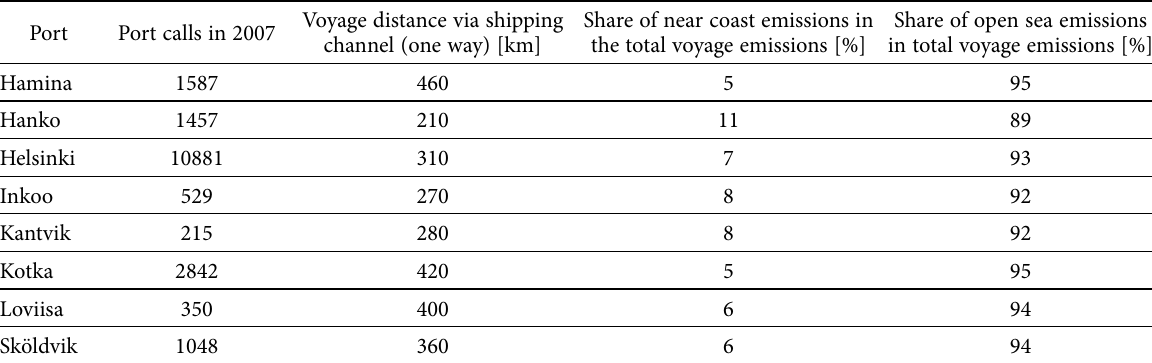
Table 1. A list of ports included in the study with a distance from each port to the Gulf of Finland exit point (see Fig. 1) and the share of the near coast (defined as the first 22.2 km of the journey from the harbour) and open sea (the area outside the initial 22.2 km) in the total voyage